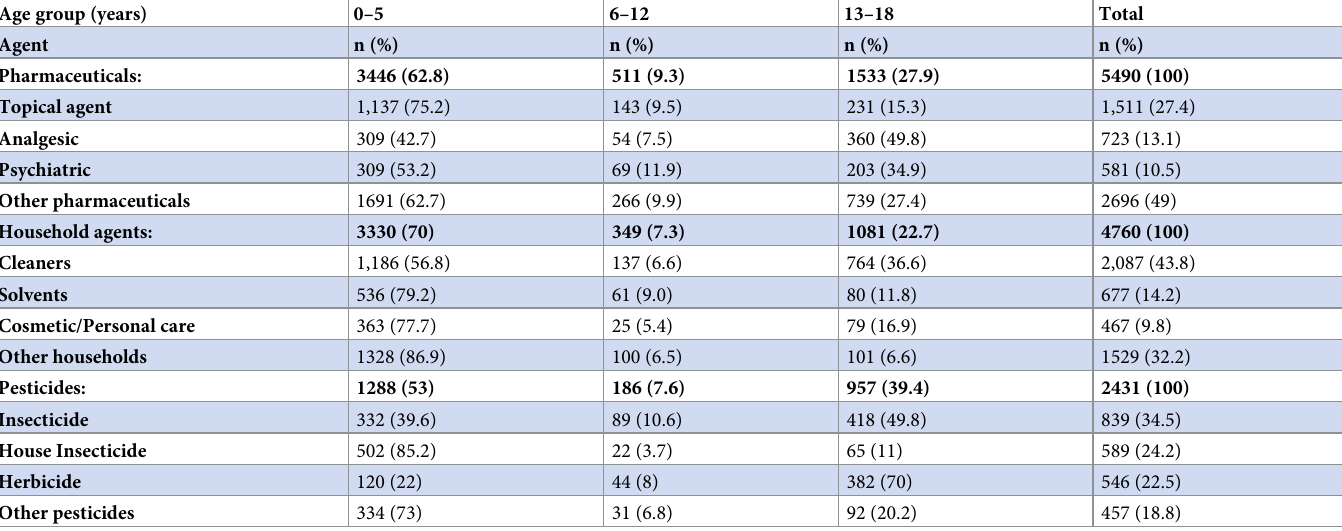
Table 2. The most common poisoning agents in children according to age